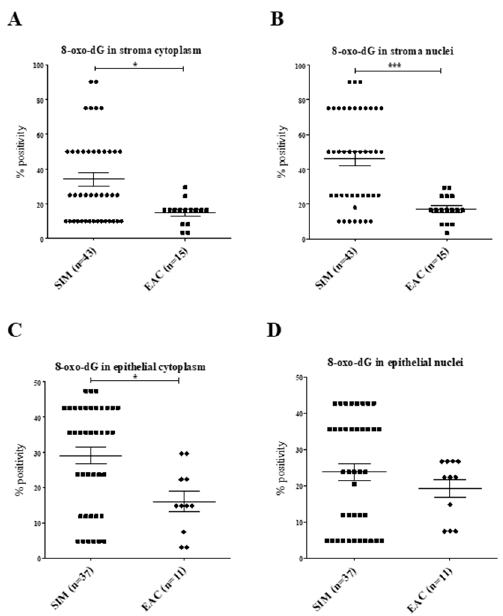
Figure 4. ( A – D ): 8-oxo-dG percentage positivity following normalization with Ki67. There were significantly increased levels of 8-oxo-dG in SIM ( A ) stroma cytoplasm, ( B ) stroma nuclei and ( C ) epithelial cytoplasm compared with EAC . (D ) No di ff erences were seen in epithelial nuclei ( p = 0.465). * p < 0.05, *** p < 0.0005.